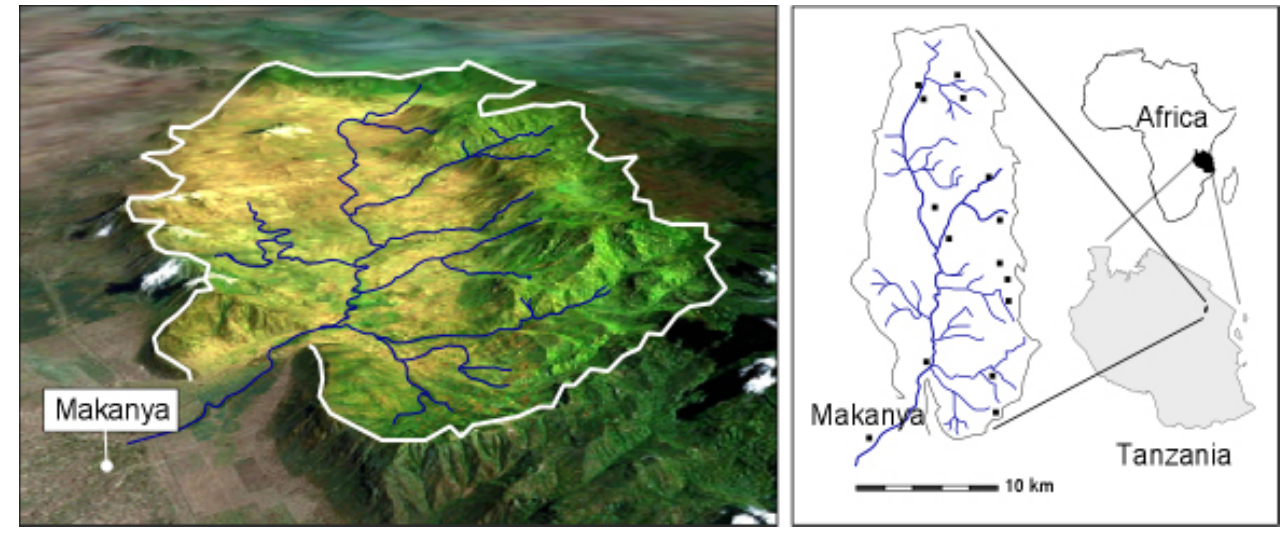
Fig. 1. The Makanya catchment. The left map shows the Makanya catchment on a satellite-image background from Google Earth/Earthsat 2005. The right map shows the position of the catchment in Northeastern